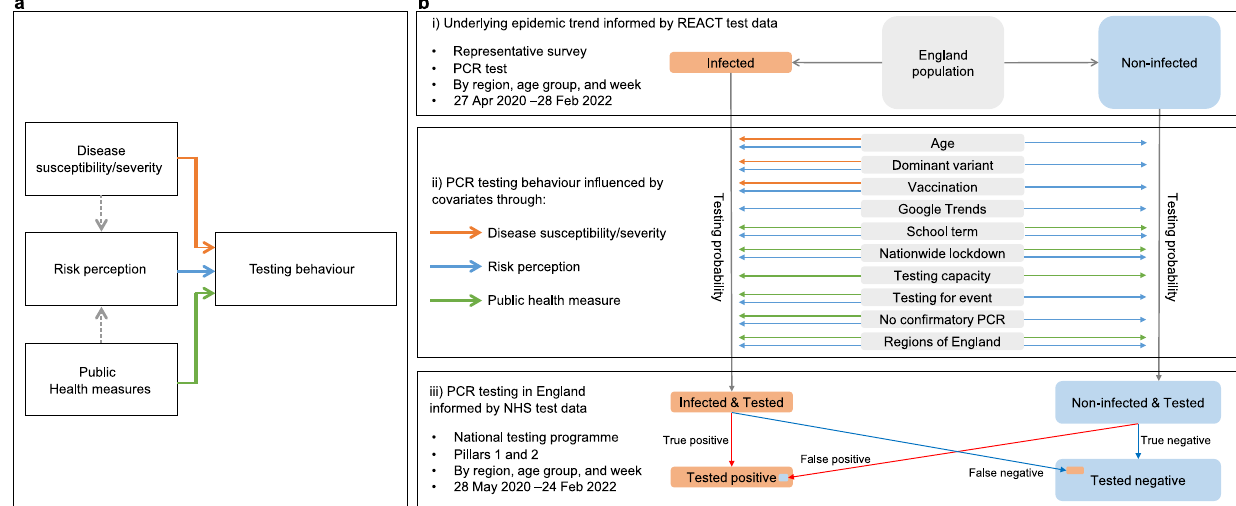
Fig. 1 | Conceptual framework for SARS-CoV-2 testing behaviour. a The rela- tionships between mechanisms proposed to in fl uence testing behaviour. The conceptual framework proposes that testing behaviour is in fl uenced by the combinedeffectof(i)diseasesusceptibility/severity,(ii)riskperception,and(iii) public health measures (solid lines). Disease susceptibility/severity and public health measures are also proposed to in fl uence risk perception (dotted lines), in addition to their direct impact on testing behaviour (solid lines). However, the indirect impact (i.e. dotted lines) could not be formally disentangled within our